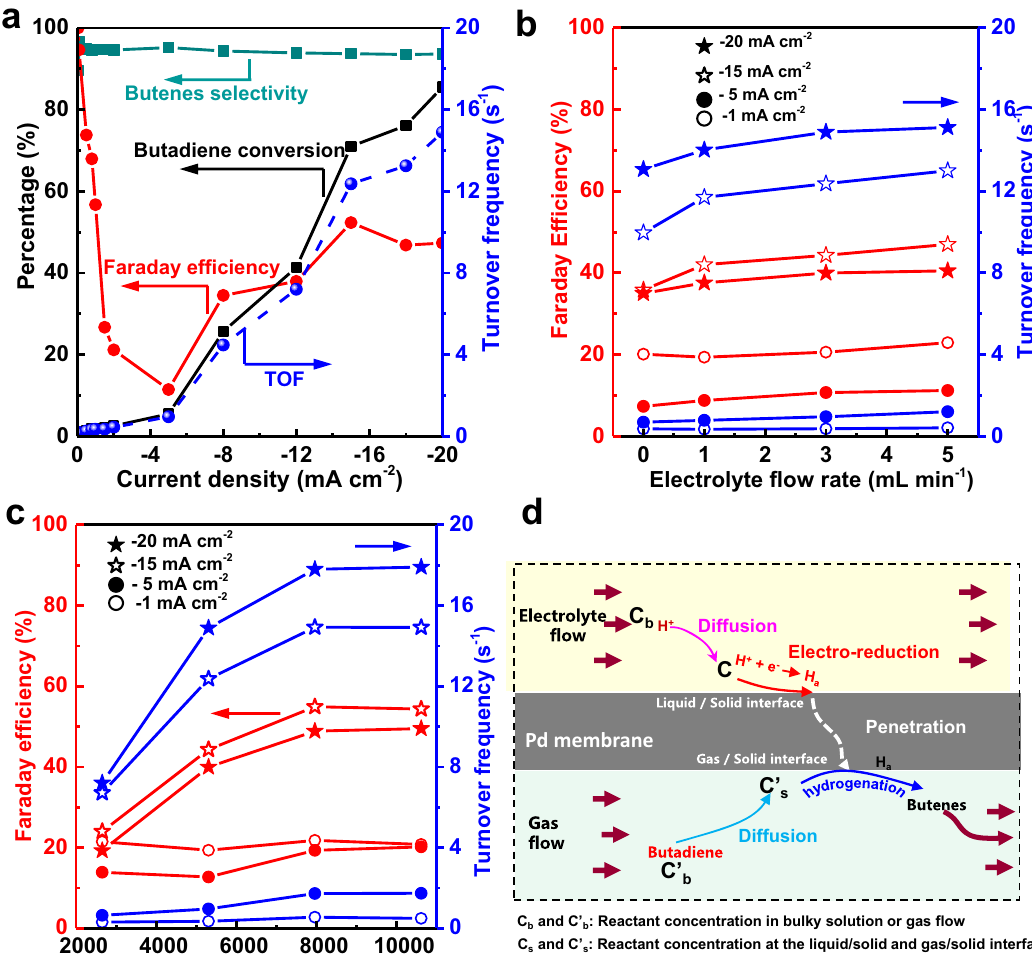
C s and C’ s : Reactant concentration at the liquid/solid and gas/solid interface